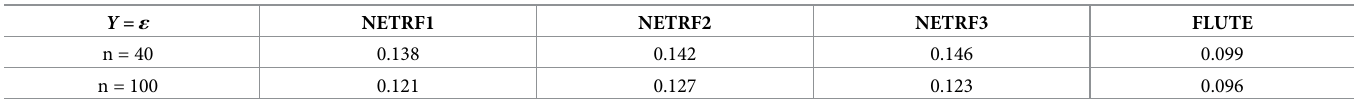
Table 8. Size for normal residual at significant level α = 0.1. Y = ε